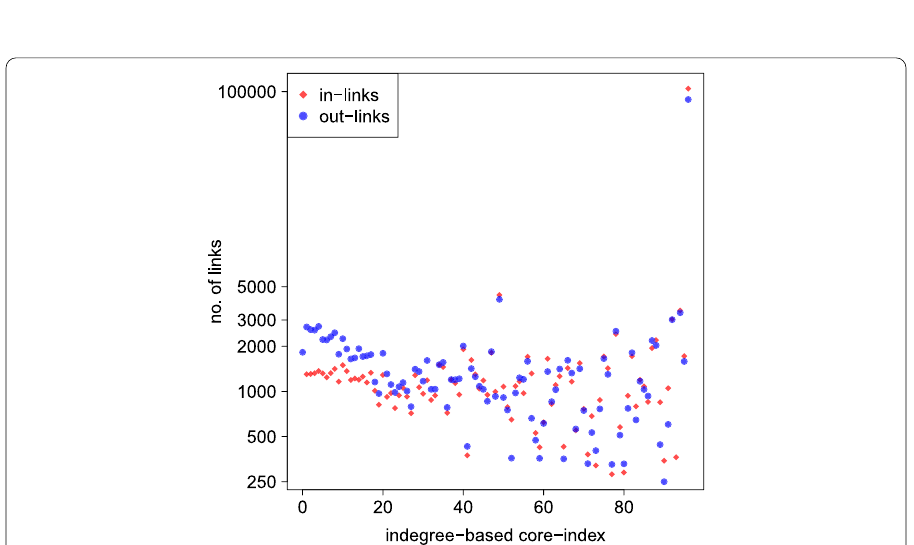
Fig. 8 Comparison between no. of in-links and out-links for each indegree-based core-index of the I nstancEs network. Values on the y-axis are log